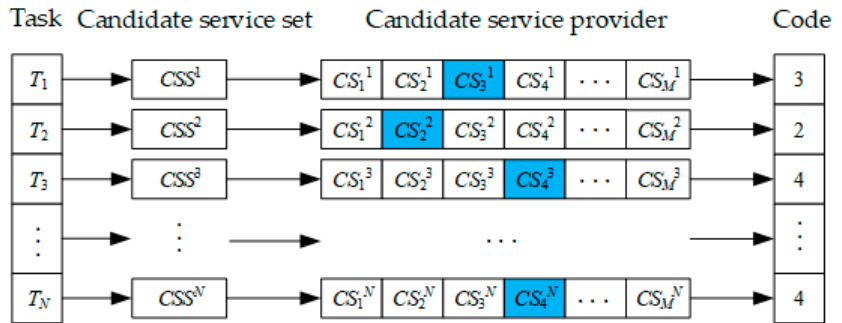
Figure 4. Chromosome encoding method of NSGA-II-SA algorithm.